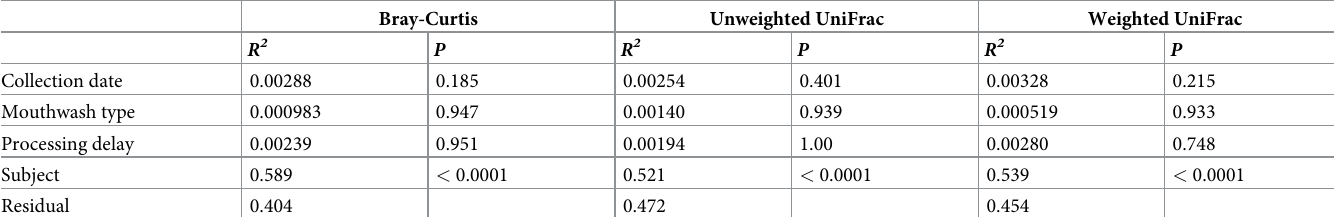
Table 2. Differences in the microbial composition by mouthwash type (ethanol-free vs.ethanol-containing) and processing delay time assessed using permutational multivariate analysis of variance (PERMANOVA).